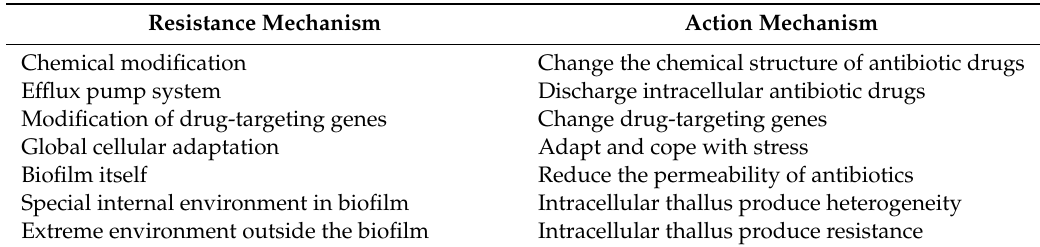
Table 1. Microbial resistance